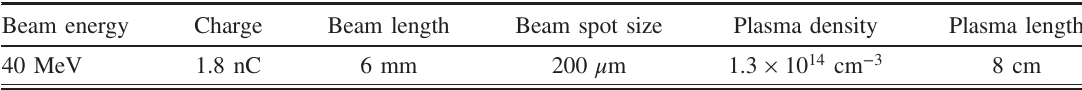
TABLE I. Parameter for the WARP simulation and experiment from the Ref. [19].